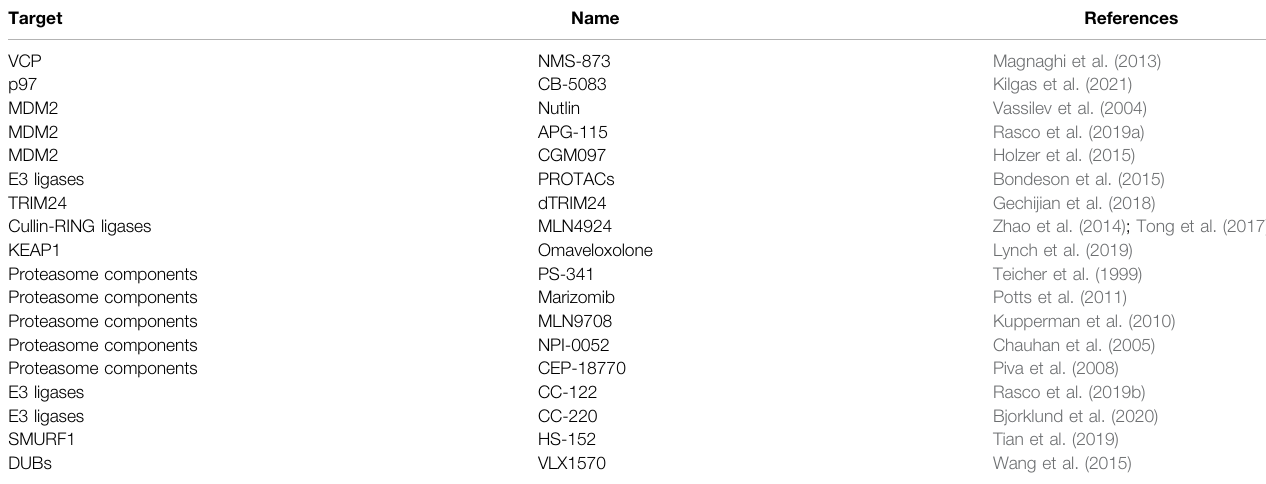
TABLE 3 | Inhibitors of ubiquitin modi fi